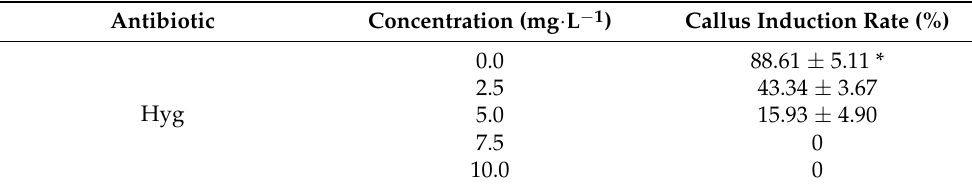
Table 1. Effects of Hyg on callus induction from leaf explants.